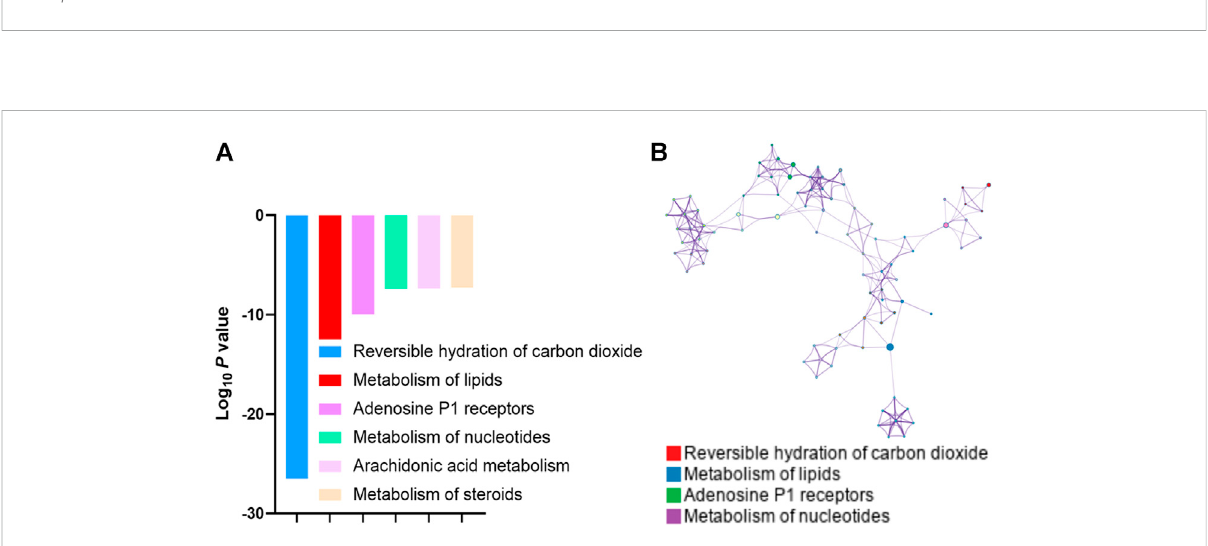
FIGURE 3 (A) Gene Ontology analysis of the potential targets of paeoni fl orin and liquiritin predicted by SwissTargetPrediction. (B) GO pathway and process enrichment analysis of each component of the interacting network member of potential targets.